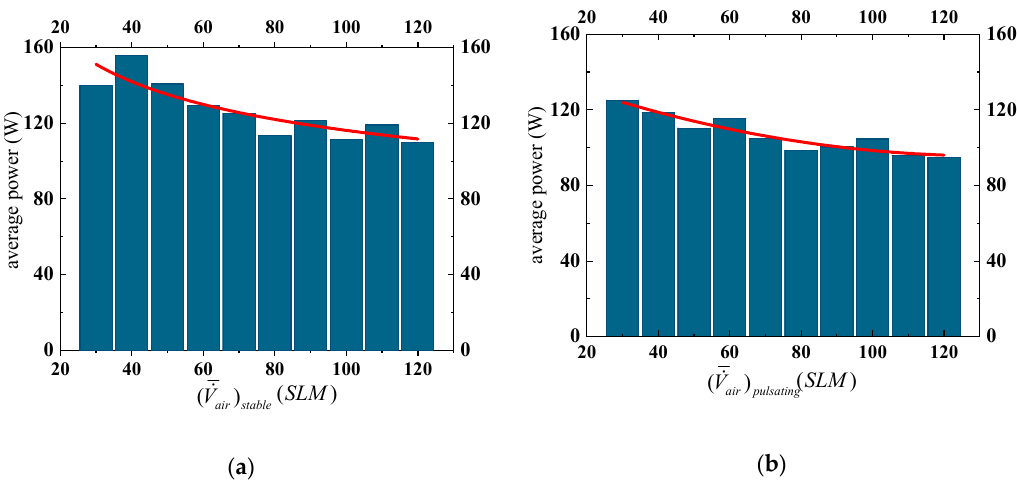
Figure 9. ( a ) The average power in stable flow mode; ( b ) The average power in pulsating flow mode.